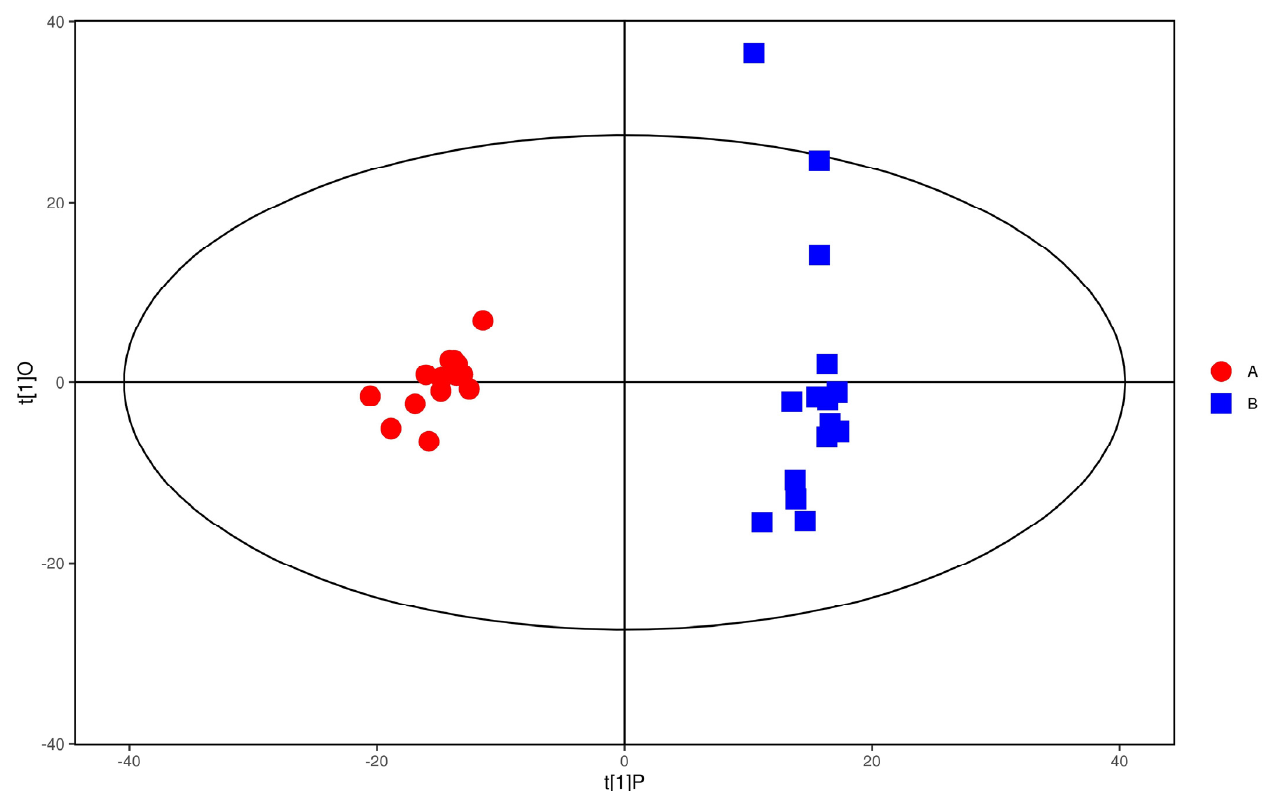
Figure 8. OPLS − DA score of anions. Red represent the control group. Blue represent the study